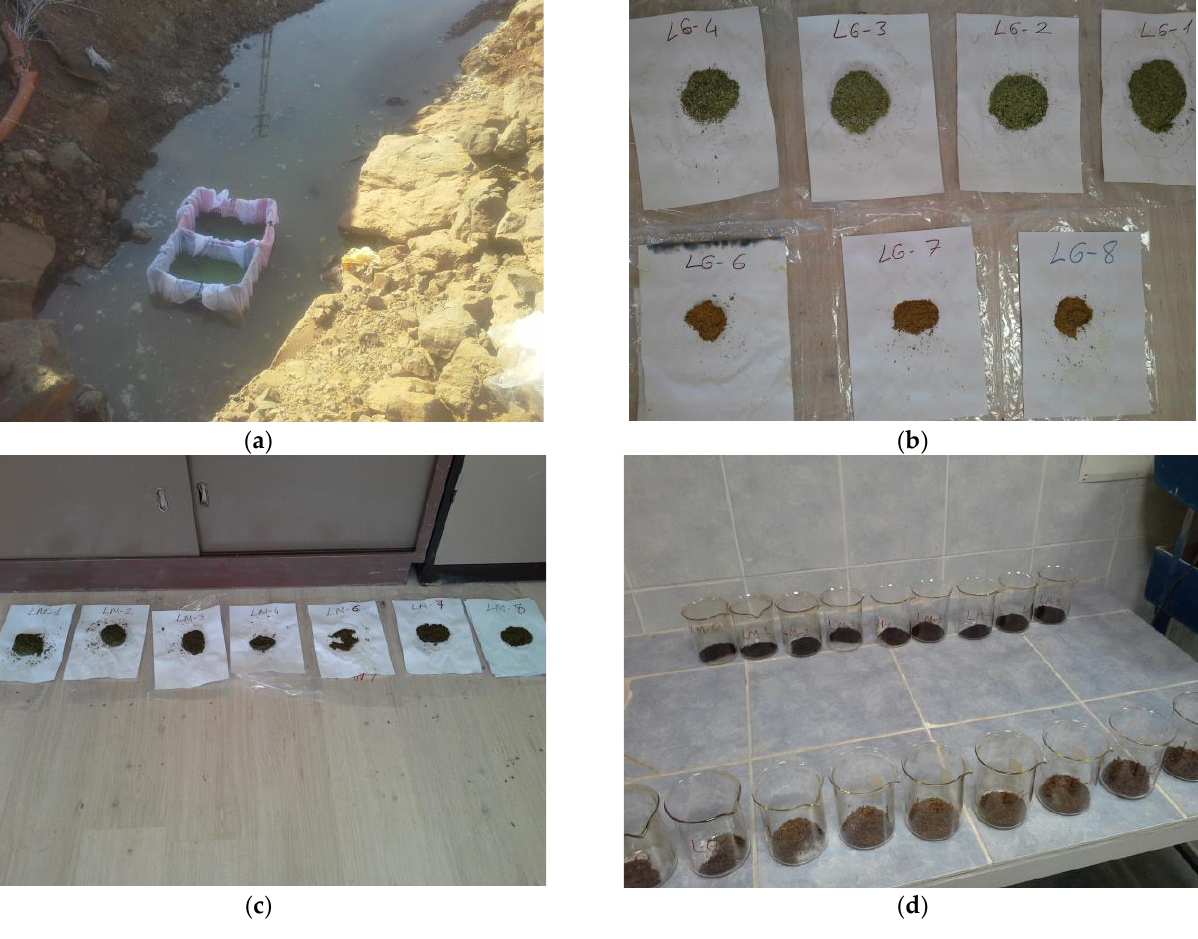
Figure 2. ( a ) L. minor and L. gibba adapted in each reactors, ( b , c ) L. gibba and L. minor samples collected at the end of the experiment, ( d ) ash samples of L. minor and L. gibba burned in the oven at 300 °C.